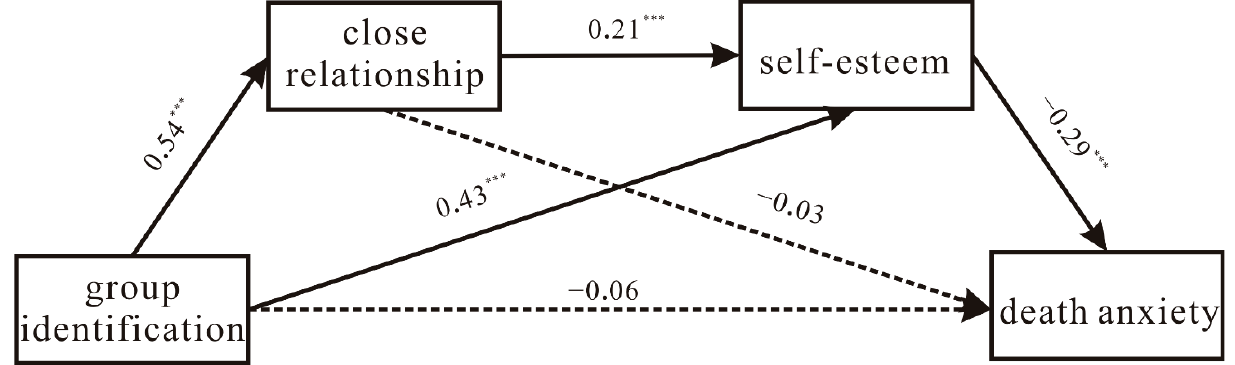
Figure 2. The chain mediation model of the impact of group identification on participants’ death anxiety. Note: Path values are standardized path coefficients. *** p < 0.001.